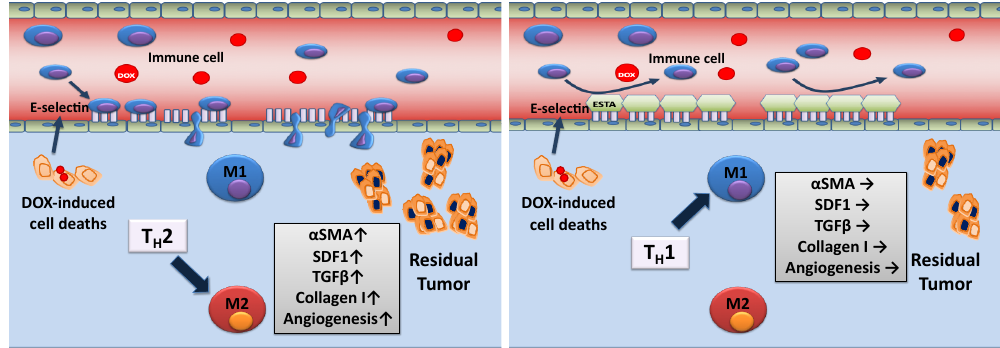
Figure 6. Schematic working model of ESTA’s mechanism of action. DOX-induced cell death provokes infiltration of immune cells through E-selectin expressing inflamed vessels, skewing the tumor towards T H 2. T H 2 cytokines induce pro-tumorigenic (proliferation and angiogenesis) and pro-fibrotic changes. The binding of ESTA to E-selectin expressing vessels obstructs the adhesion of immune cells to the luminal surface of vessels, subsequently suppressing DOX treatment-induced pro-tumorigenic and pro-fibrotic changes.